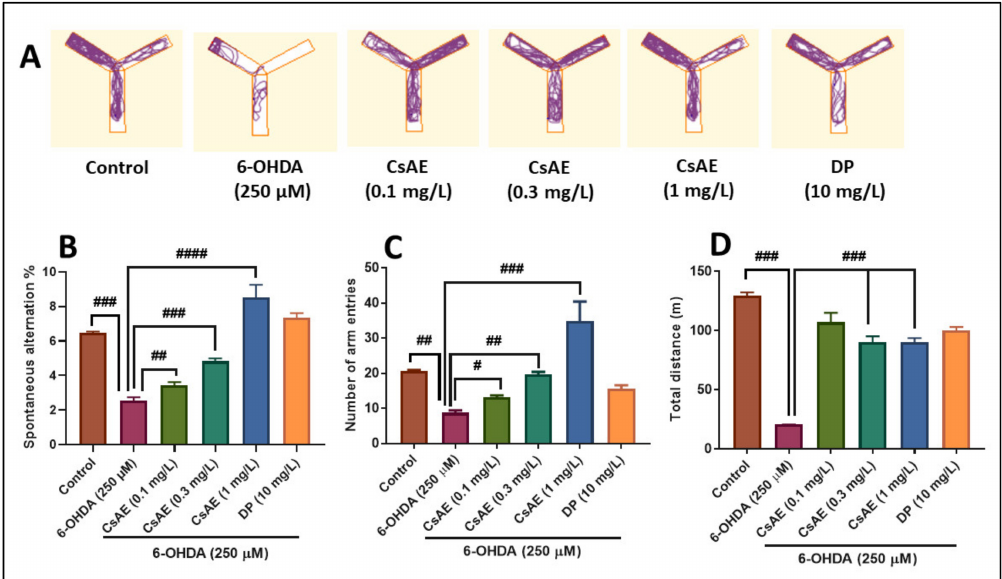
Figure 5. Ceratonia siliqua aqueous extract (CsAE, 0.1, 0.3, and 1 mg / L) improved locomotion pattern and memory in the Y-maze test. ( A ) Representative locomotion tracking of the control, 6-OHDA (250 µ M) CsAE (0.1, 0.3, and 1 mg / L), and donepezil (DP) (10 mg / L) treated groups. ( B ) Represent the percentage of spontaneous alternation in the Y-maze in di ff erent groups. ( C ) Represent the number of arm entries in the Y-maze in di ff erent groups. ( D ) Represent the total distance travelled by zebrafish in the Y-maze in di ff erent groups. Values are means ± S.E.M. ( n = 10). For Tukey’s post hoc